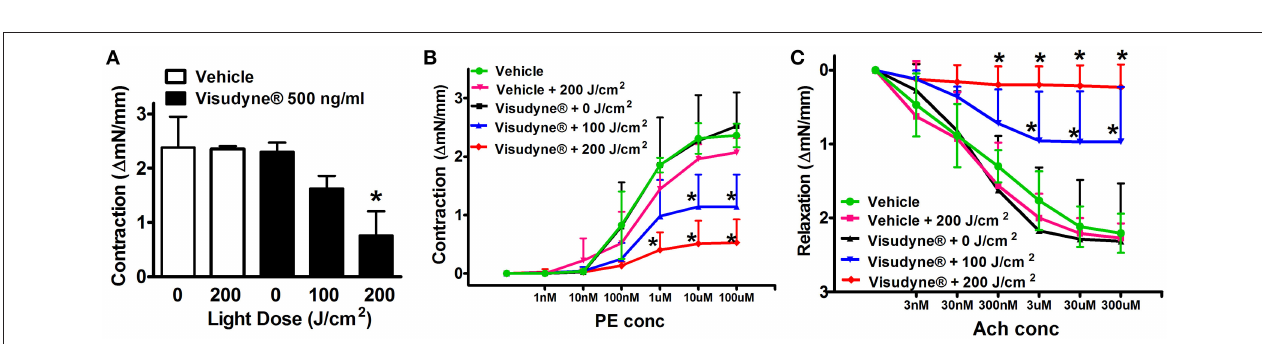
FIGURE 8 | Visudyne ® -PDT reduces vascular function. Aortic segments devoid of plaque from different treatment groups were mounted in Myograph. (A) Bar diagram representing KCl induced contraction (B) Dose-dependent phenylephrine (1nM–100 µ M) induced contractions and (C) Acetylcholine (3nM–300 µ M) mediated relaxations. Results are mean ± SD ( n = 4). * p < 0.05 vs. Visudyne ®